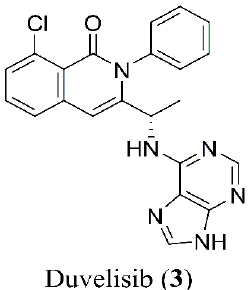
Figure 2. Chemical structure of duvelisib ( 3 ).